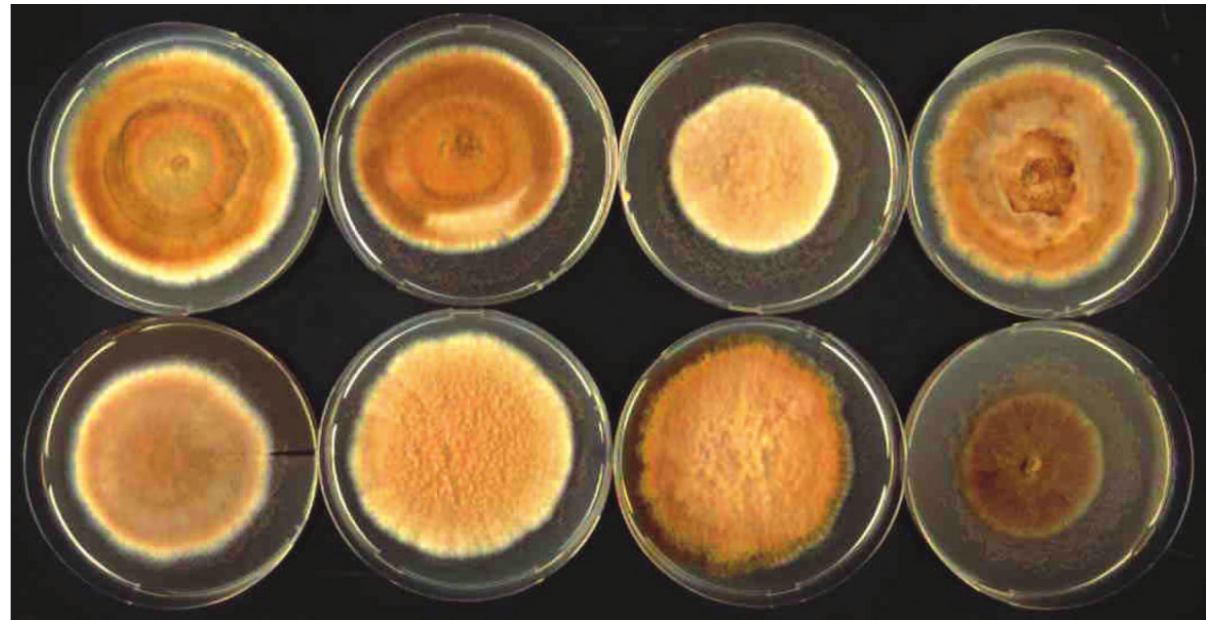
Fig. 3. Fomitiporia mediterranea . Isolates after three weeks cultivation at room temperature. Note differences in colour and growth